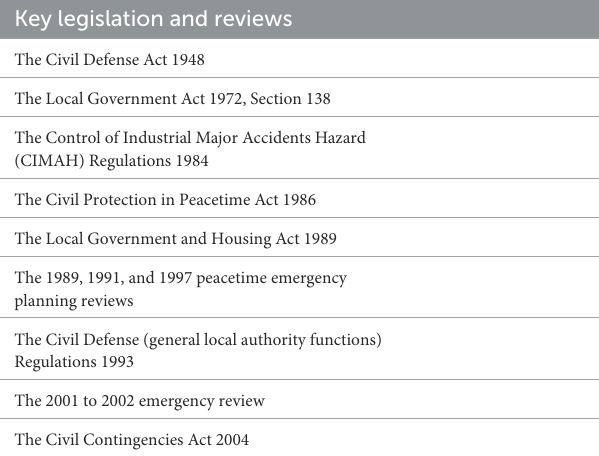
TABLE 4 Key legislative reforms and reviews of emergency management structure and